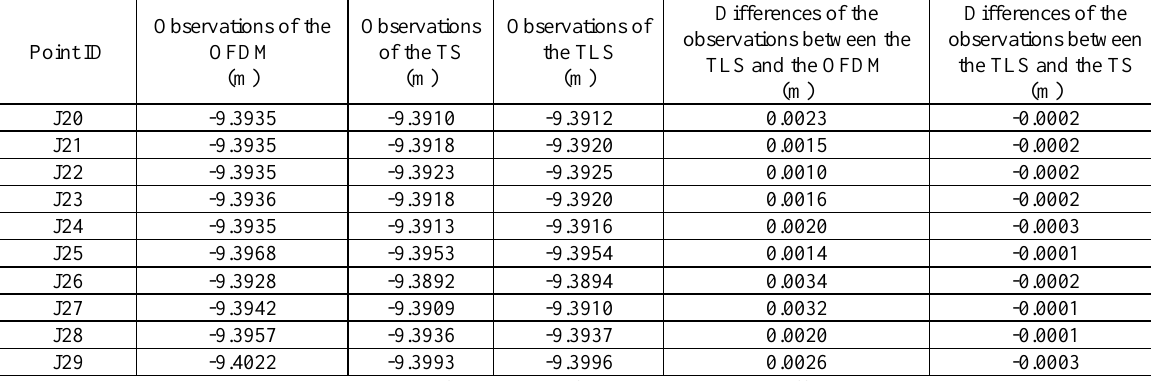
Table 11. Comparison of three kinds of results monitored by different